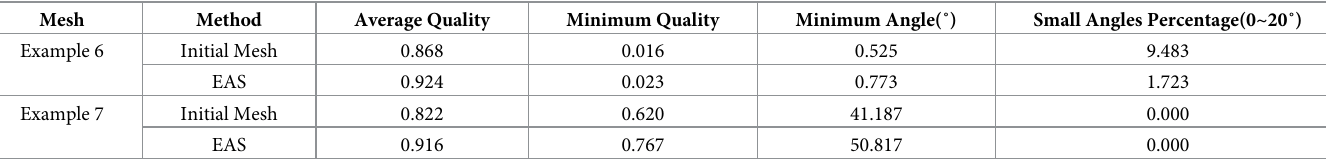
Table 2. Test results of complex